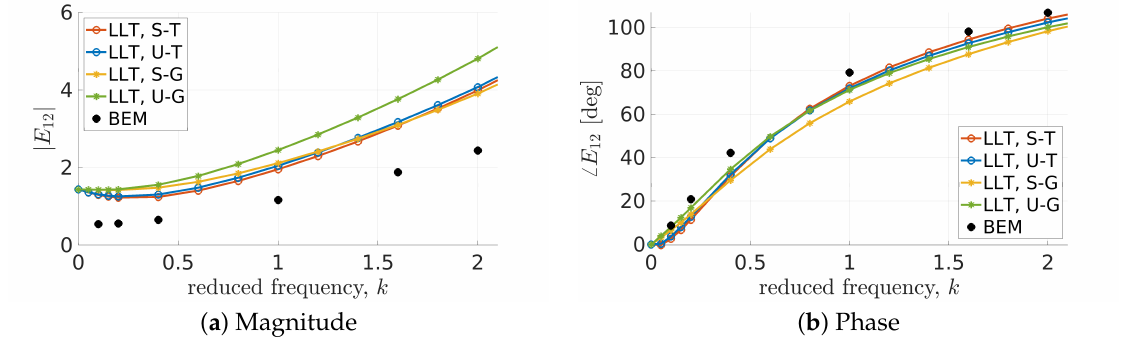
Figure 11. Transfer function E 12 ( k ) , NMV shape functions, l = 1.25m.